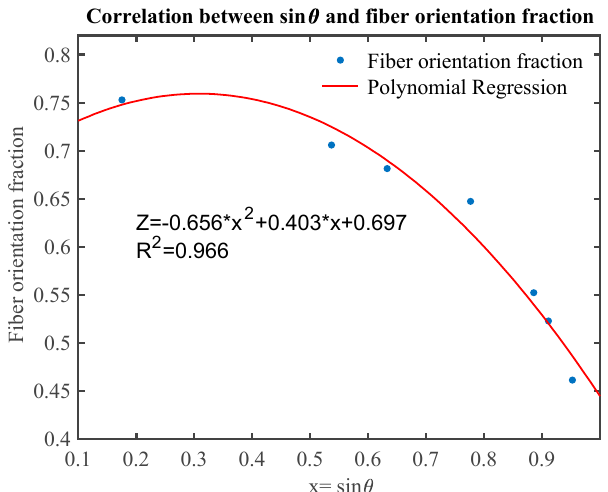
Figure 13. Predicted and measured thermal conductivities of nonwoven samples.